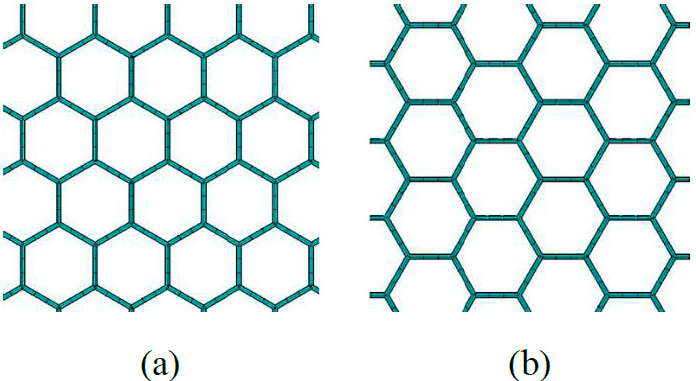
Figure 1. Graphene sheets with beam finite elements ( a ) is for the Zigzag type and ( b ) is for the Armchair type.